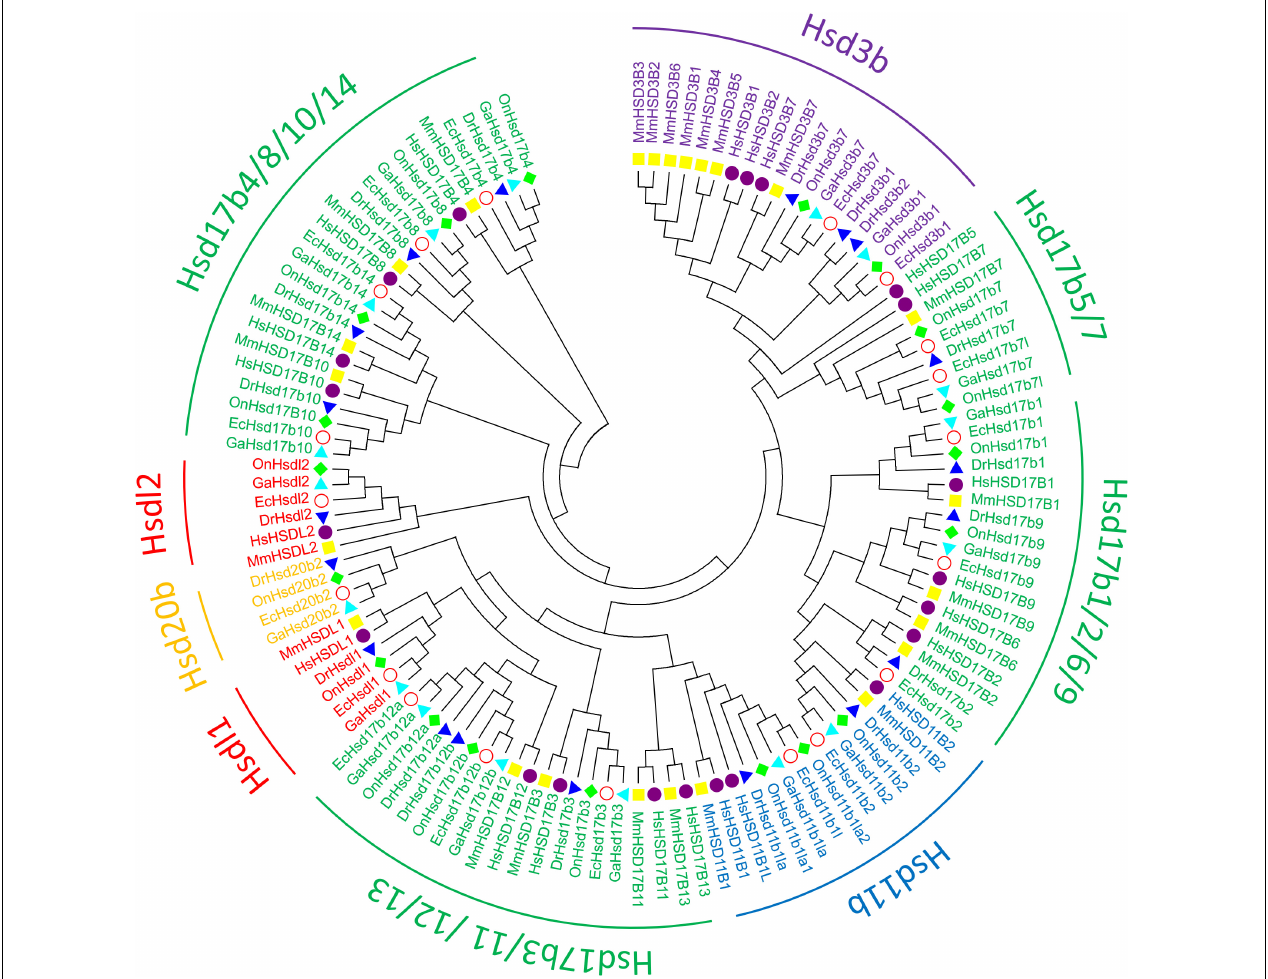
FIGURE 3 | Phylogenetic relationships of β -Hsd proteins from grouper and other five species. The phylogenetic tree was constructed using MEGA7 by Maximum Likelihood method with the amino acid sequences of β -Hsd from grouper ( Epinephelus coioides , Ec), ( Homo sapiens , Hs), mouse ( Mus musculus , Mm), zebrafish ( Danio rerio , Dr), tilapia ( Oreochromis niloticus , On), and stickleback ( Gasterosteus aculeatus , Ga).